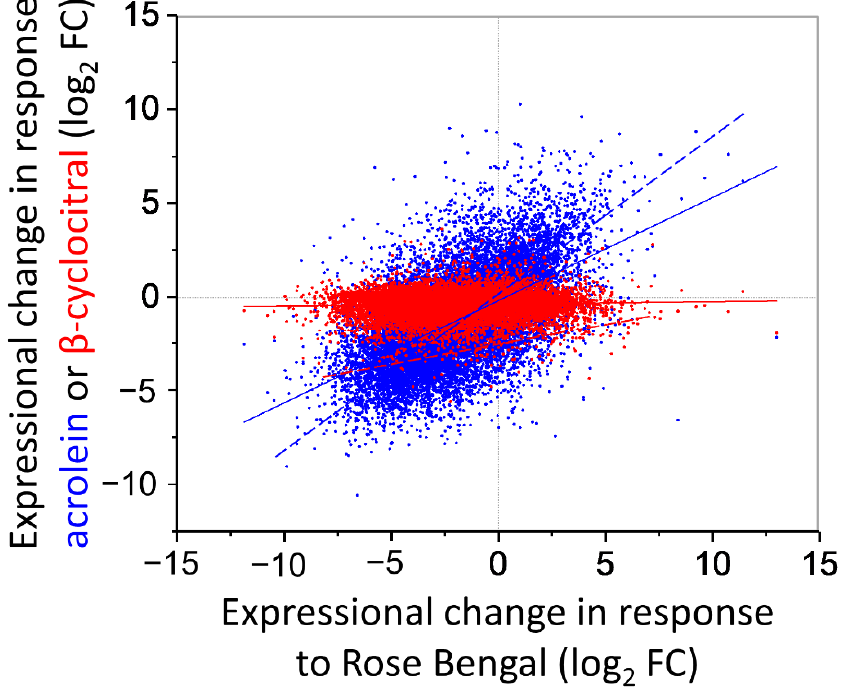
Figure 5. Correlation of differential gene expression induced by treatment with 1 O 2 and acrolein (blue) or 1 O 2 and β -cyclocitral (red). Levels of mRNA are expressed as log 2 fold changes (log 2 FC), relative to mock-treated cells, calculated from RNA-Seq analyses; n = 3 for treatments and controls. Treatments with acrolein and β-cyclocitral were at 600 ppm and 1 O 2 was induced by rose bengal (RB; 1 μM under growth light at 50 μmol quanta m −2 s −1 ). Continuous and dashed lines of best fit consider all and only significantly affected genes, respectively. See Table S1 for expression levels of each gene. RNA-Seq data for acrolein and RB treatments adapted with permission from [13] 2018, Copyright Elsevier.